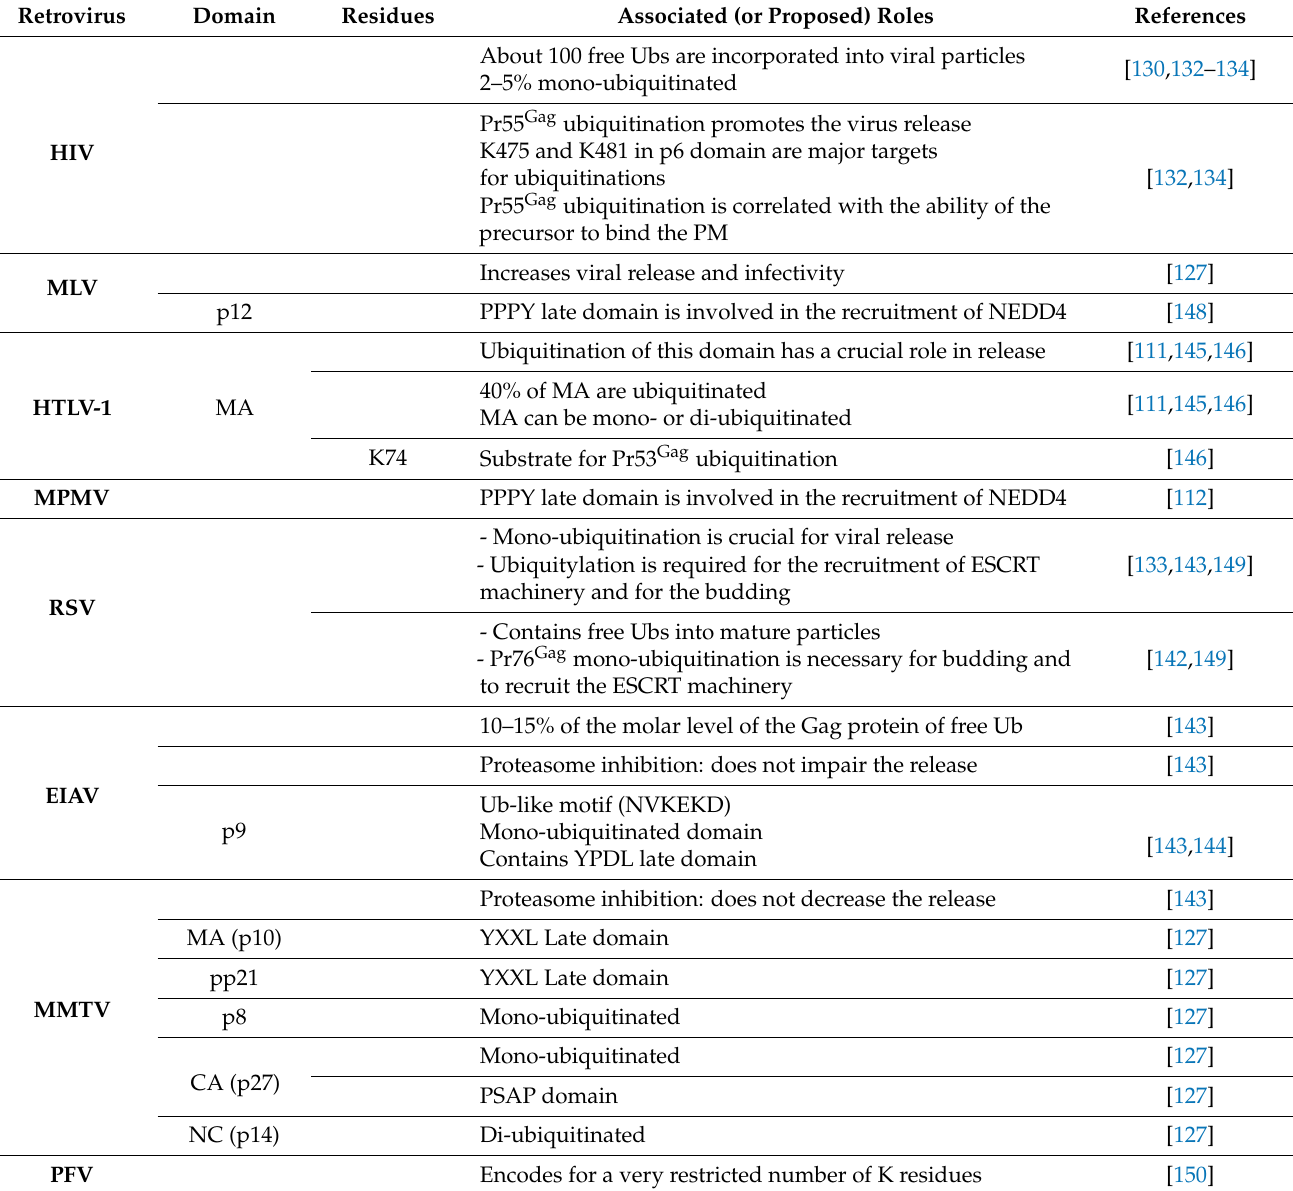
Table 4. Summary of ubiquitinations in the different domains of retroviral Gag